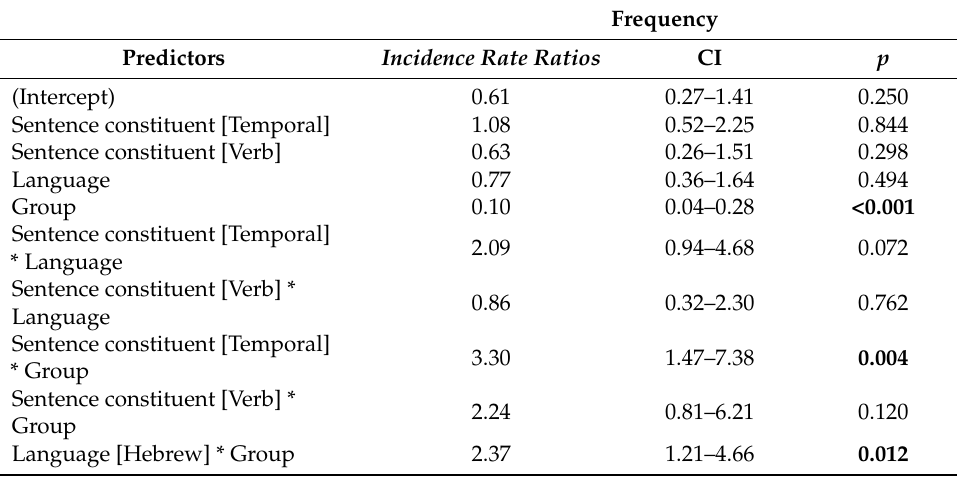
Table 5. Estimates of the model predicting the frequency of non-targeted